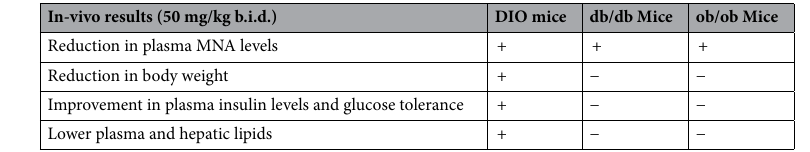
Table 6. Summary of in-vivo profiling in diabetic mice with JBSNF-0000028 after oral administration of 50 mg/kg b.i.d.